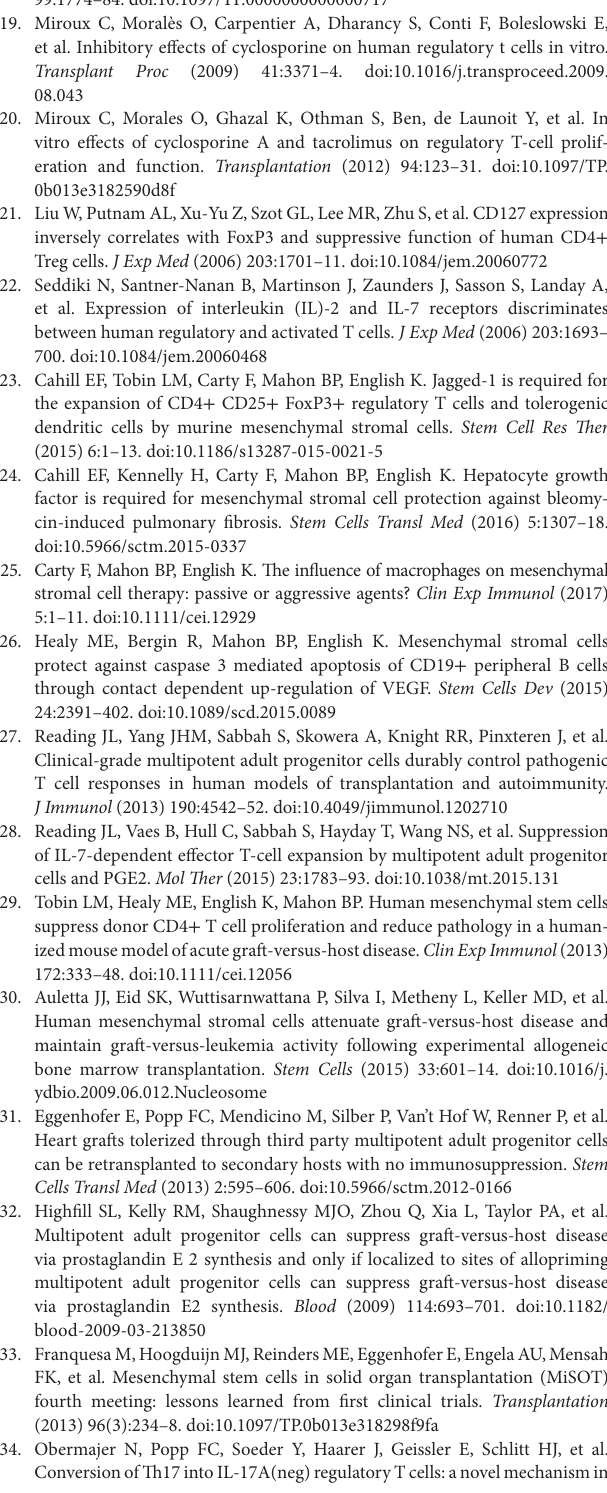
FigUre s3 | Indomethacin does not impair interferon- γ (IFN- γ ) production by T cells following anti-thymocyte globulin (ATG) administration. ATG was administered on days 0 and 3 followed by intraperitoneal (IP) injection of 30 µg